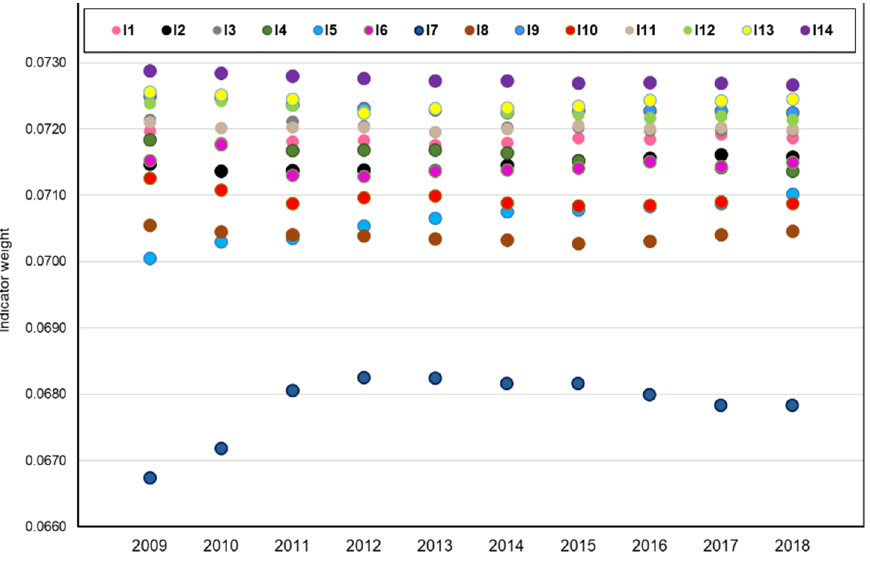
Figure 3. Indicator weight.